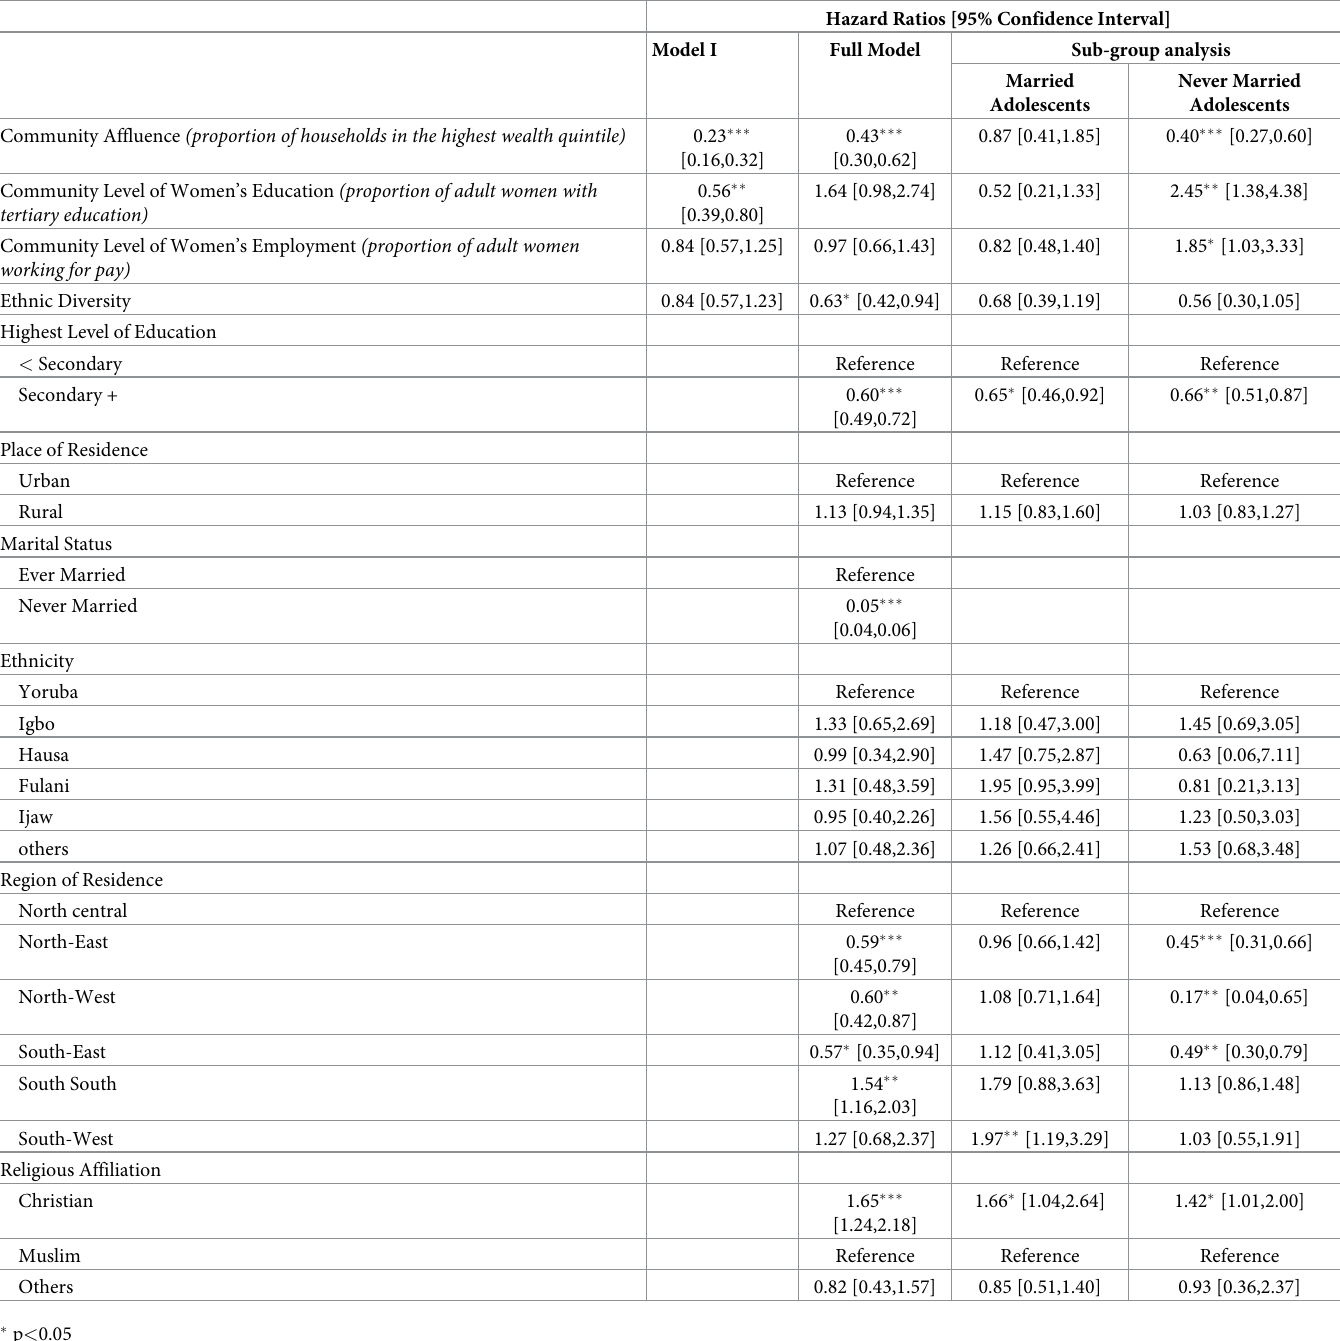
Table 3. Multivariate multi-level mixed effect parametric analysis of timing of sexual debut among adolescents in